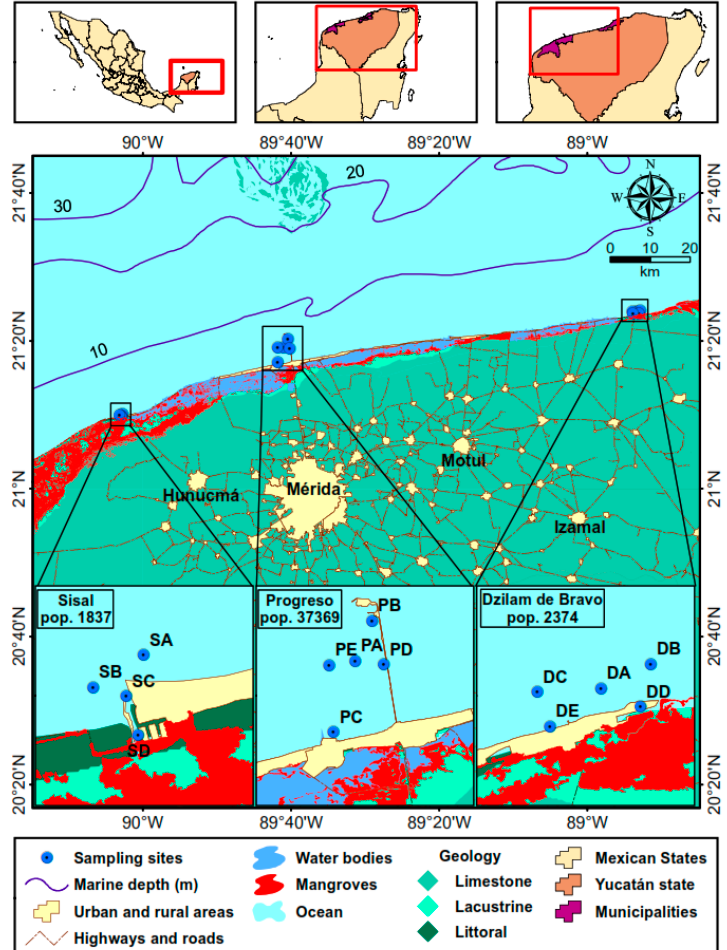
Figure 1. Locations of marine sediment sampling sites in the ports of Sisal, Progreso and Dzilam in the Yucatan Peninsula, Mexico.